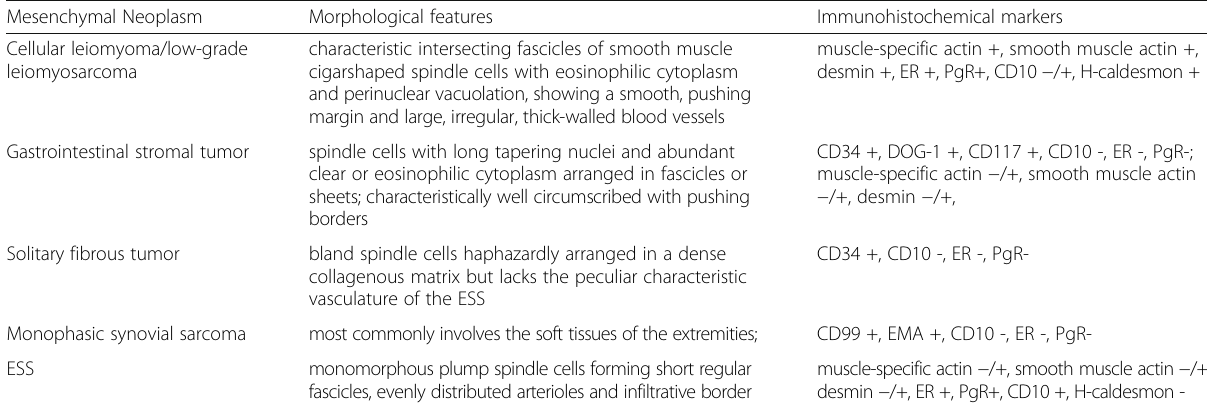
Table 2 Morphophenotypic features of the most common mesenchymal spindle cell neoplasms in the differential diagnosis of EESS Mesenchymal